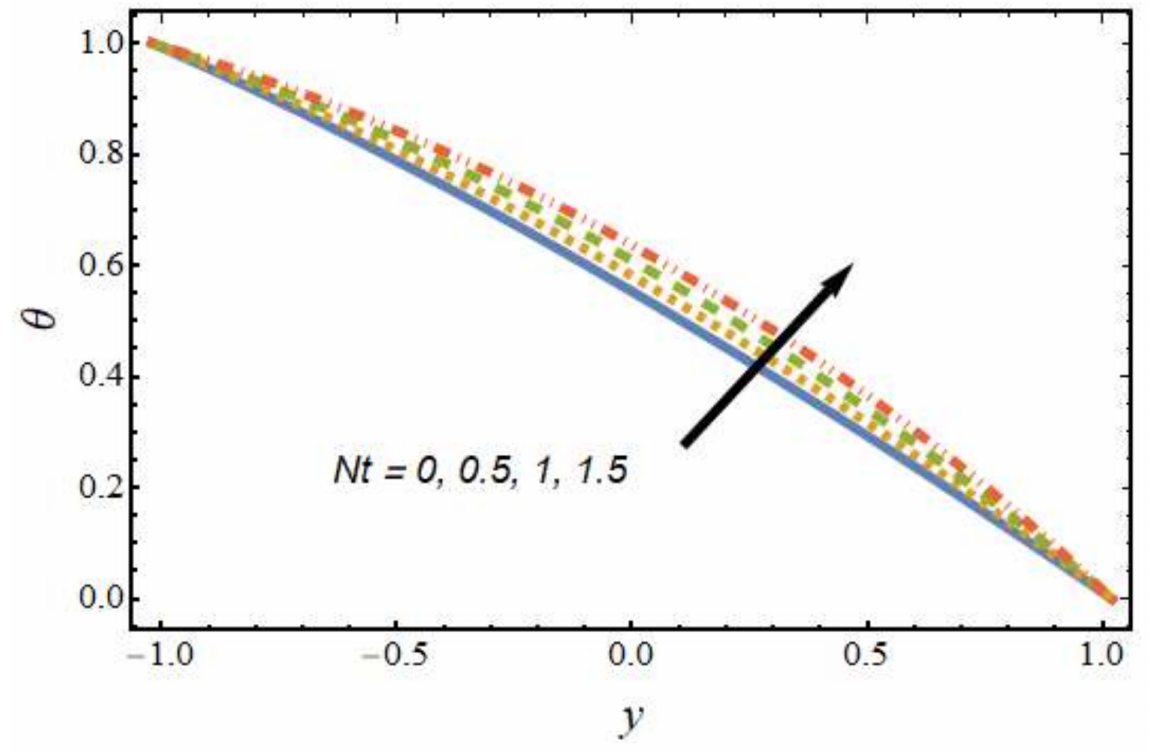
Figure 9. Nanoparticle temperature profile for various values of the thermophoresis